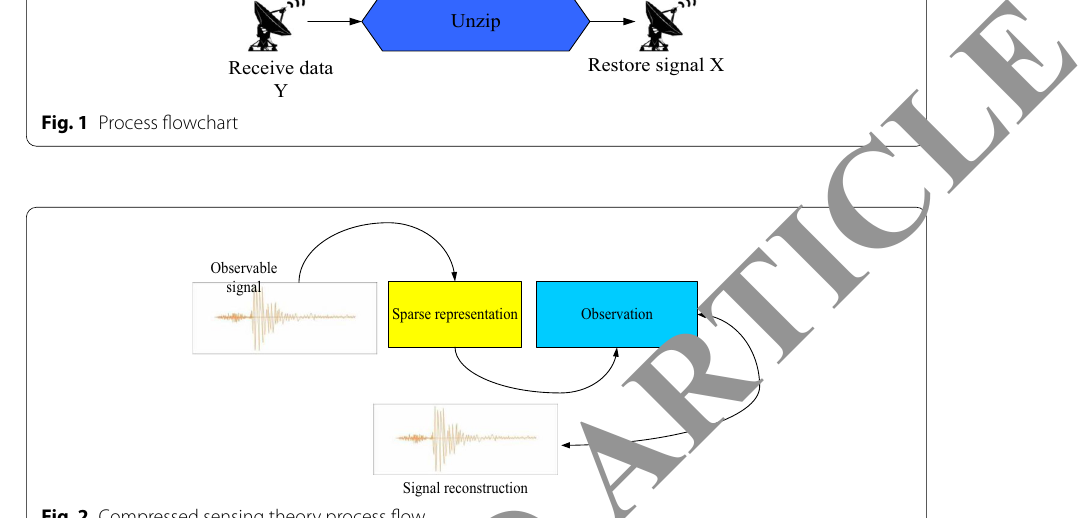
Fig. 2 Compressed sensing theory process